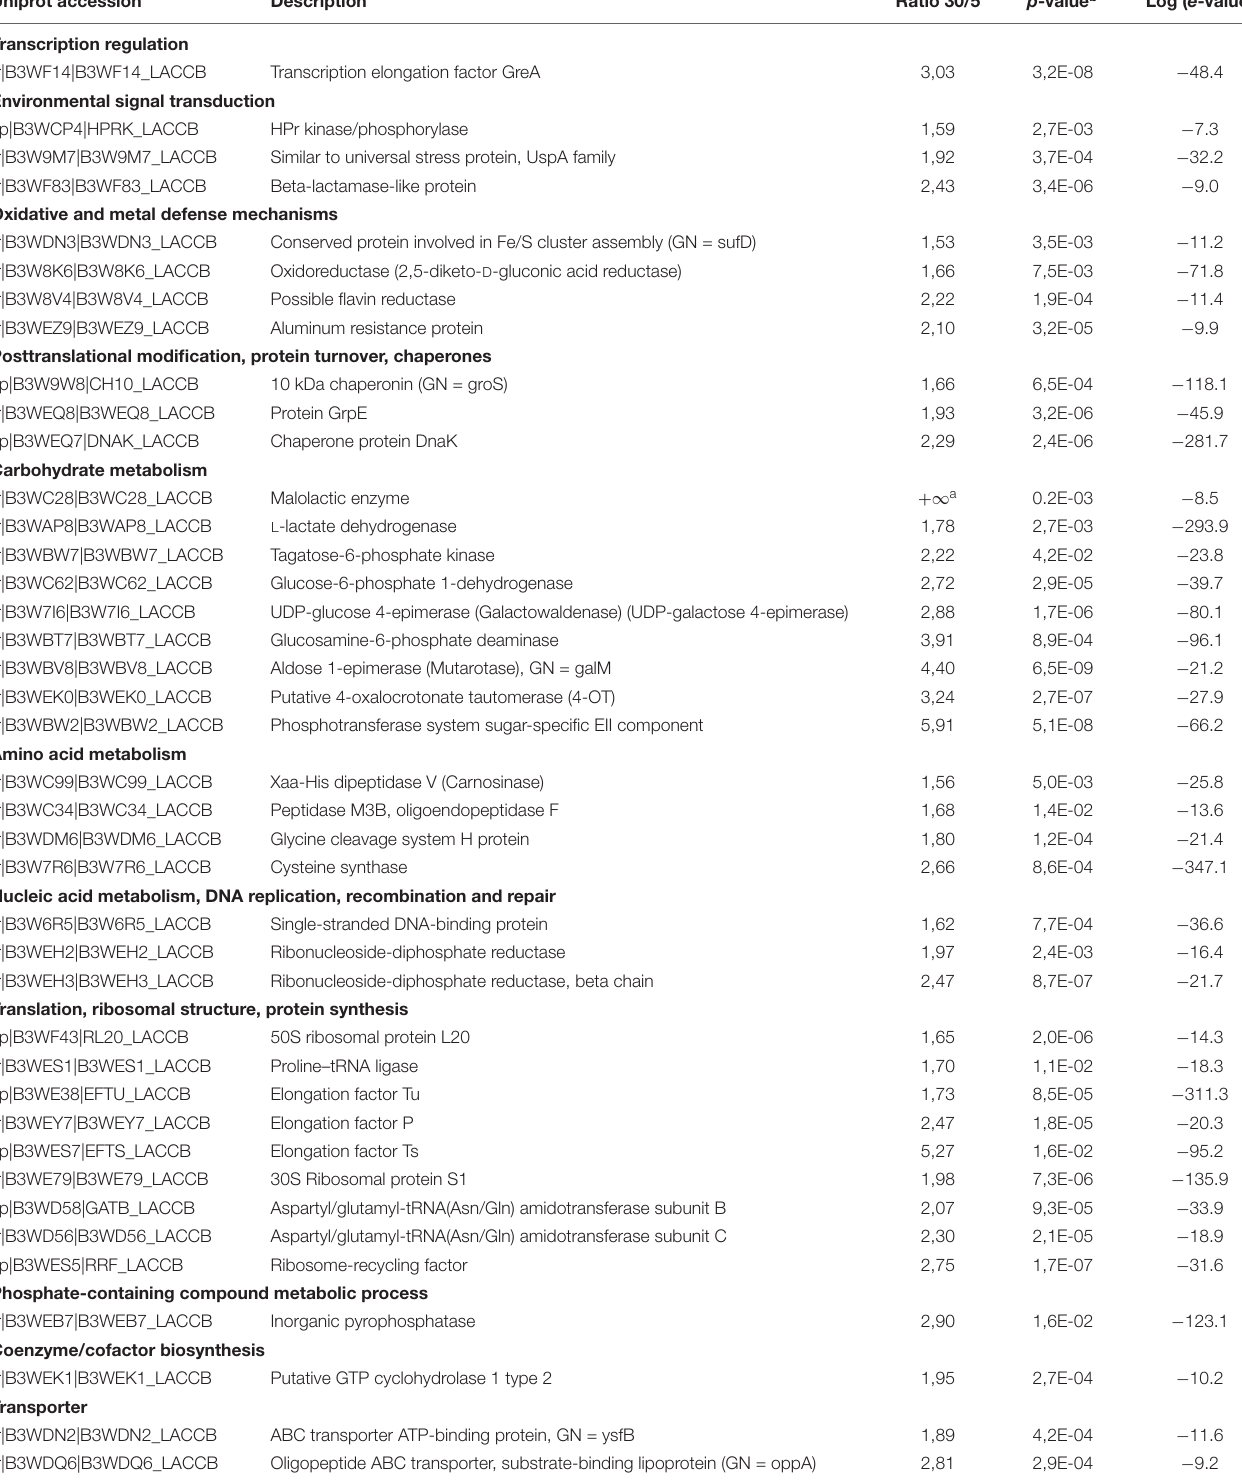
TABLE 1 | Proteins overexpressed after growth in hyperconcentrated 30% sweet whey, as compared with isotonic 5% sweet whey. Uniprot accession